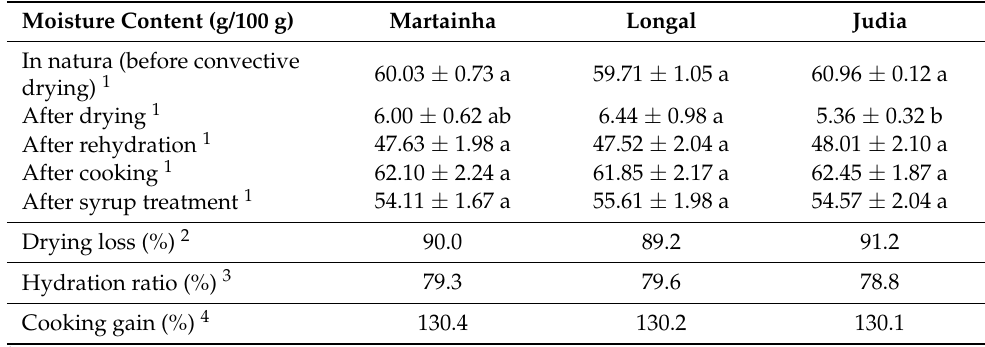
Table 2. Moisture content of the regional cultivars of chestnut